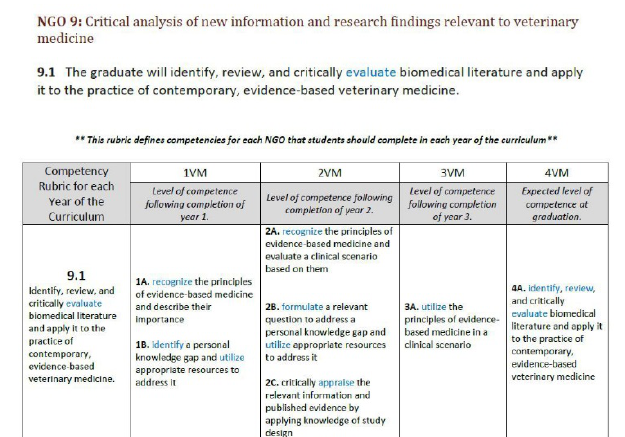
Figure 4 CVM’s information skills and behaviors outcome